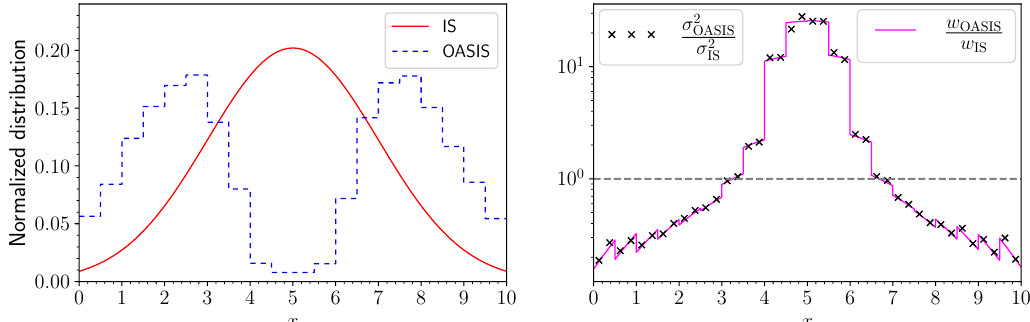
Figure 2: The blue dashed line in the left panel shows the sampling distribution trained using OASIS with L / N set to 1. For comparison, the true distribution s ) , which is the ideal case in regular importance sampling (IS), is shown with f ( x ; θ 0 the red solid line. The magenta line in the right panel shows the ratio of weights for events sampled under the OASIS-trained distribution (41) versus events sampled under the best-case scenario in regular IS (i.e., g matching f perfectly). The × marks indicate the ratios of the squares of the estimated error-bars within each bin for the histograms in Figure 3 produced under OASIS and